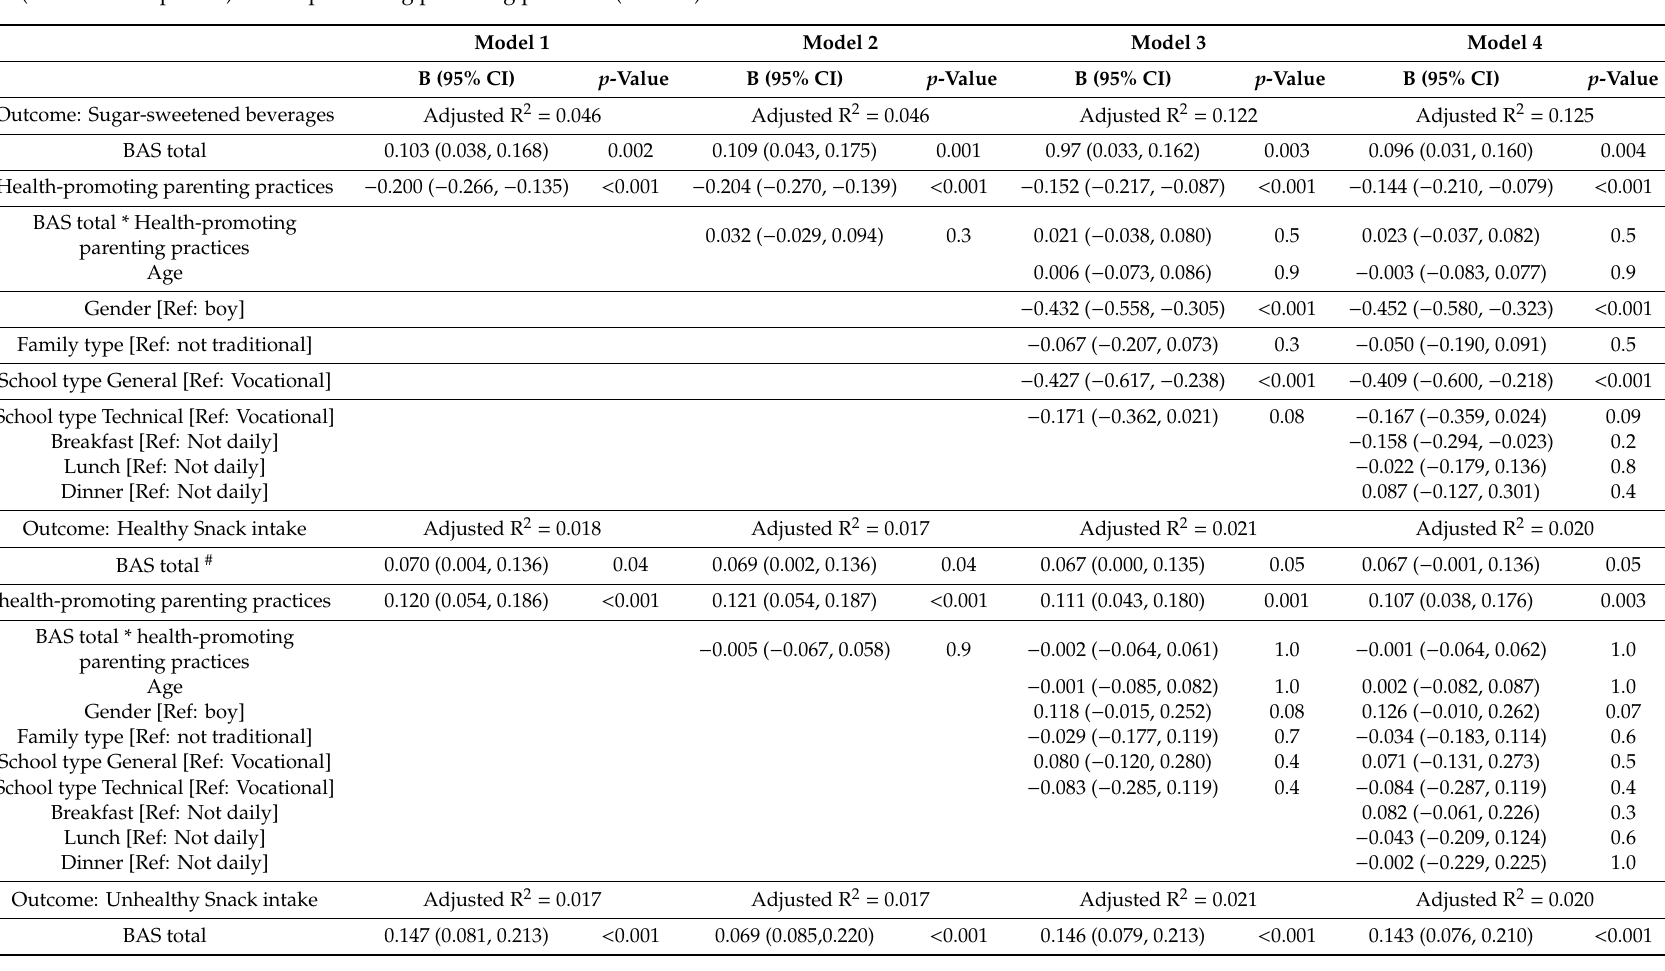
Table 2. Associations between reward sensitivity and adolescents’ intake of sugar-sweetened beverages, healthy and unhealthy snacks, and the moderating role of (adolescent-reported) health-promoting parenting practices ( n =